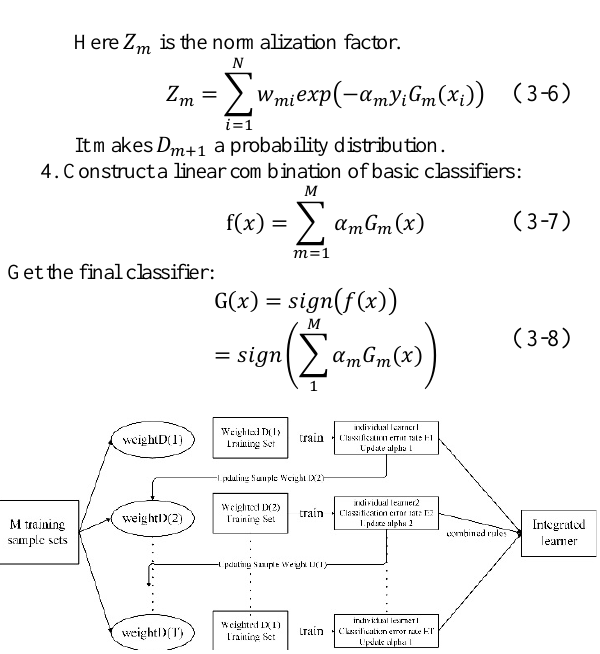
Figure 4. Schematic diagram of AdaBoost